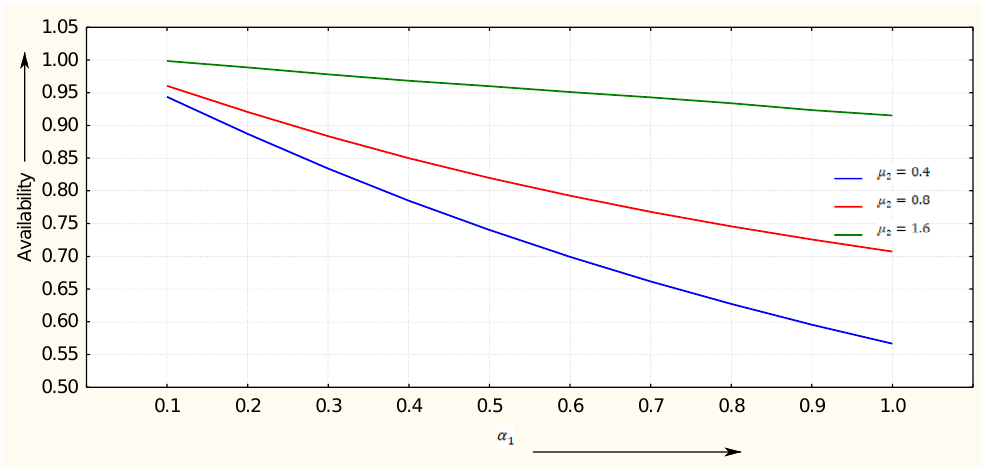
Figure 7. Behaviour of availability w.r.t. 𝛼